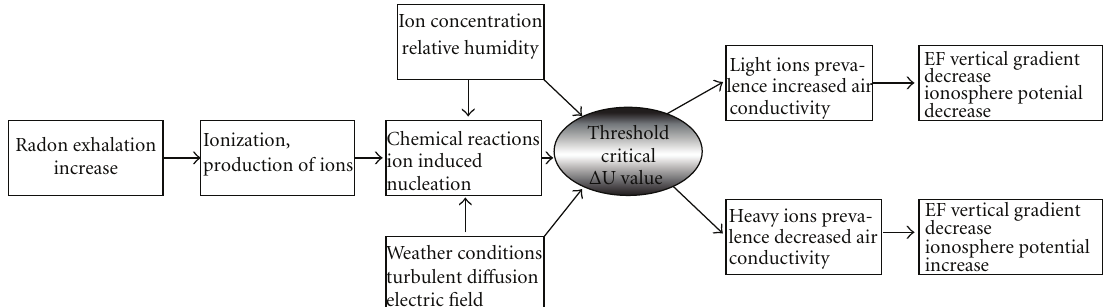
Figure 9: Flow chart diagram of the ionization and nucleation processes with the branching point (oval) in formation of light and heavy ions and air conductivity